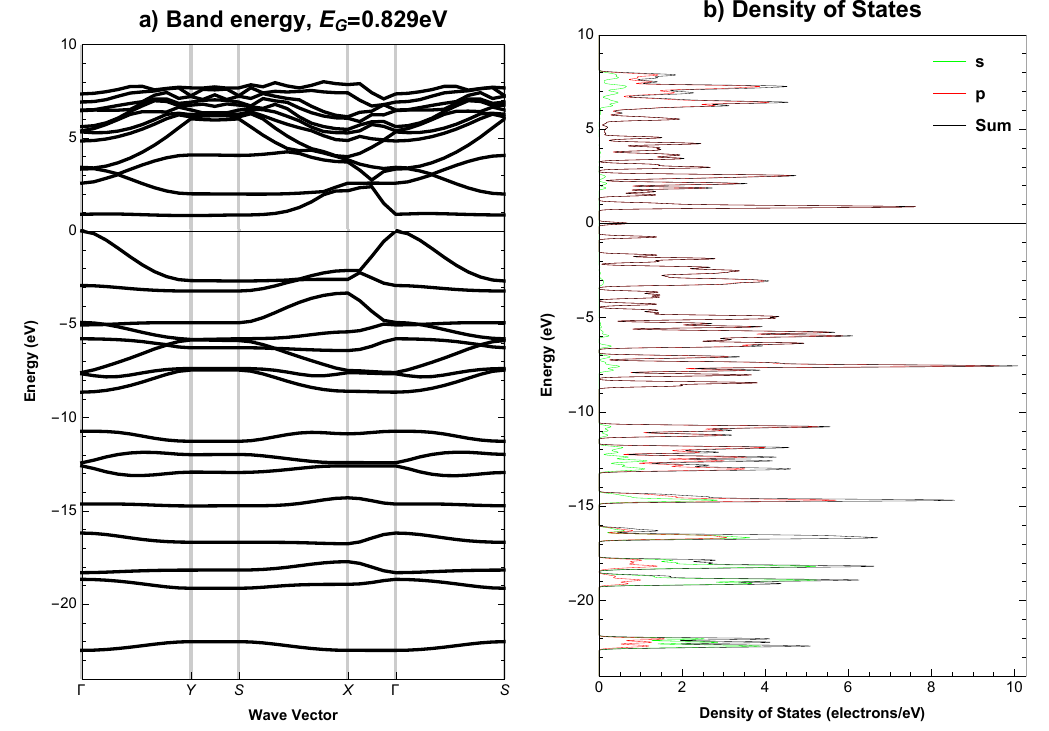
Figure 4. Anisotropic-cyclicgraphene —( a ) electronic band structure and ( b ) total and partial density of states (HSE06 functional). The Fermi level E F is set to